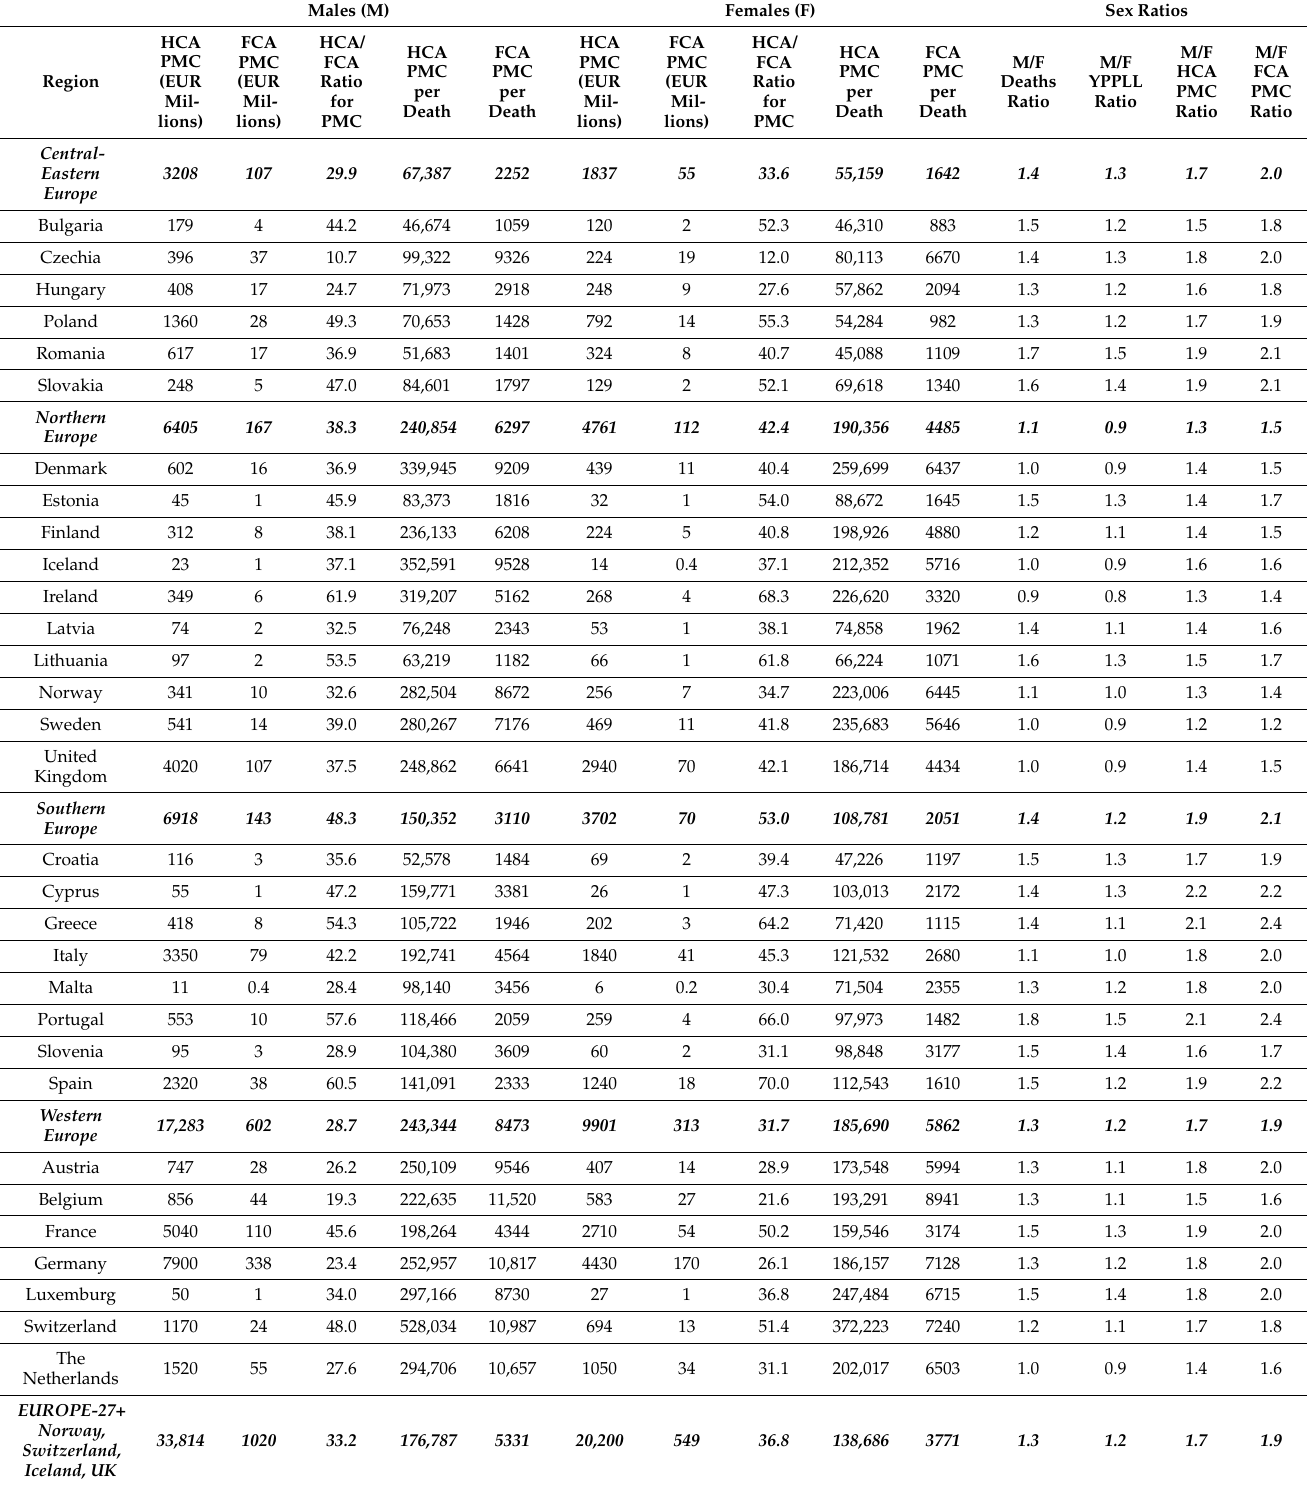
Table 2. Cancer *-related premature mortality costs (PMC) (EUR, total and per cancer death) by Human Capital Approach (HCA) and Friction Cost Approach (FCA) for Europe by region and country and sex in